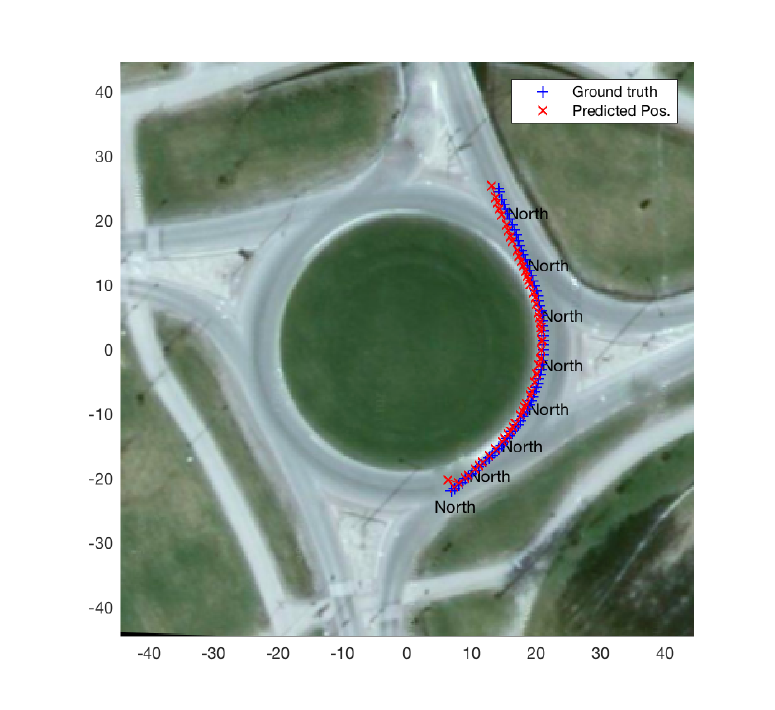
Figure 4. Exit direction classification and position prediction for a query trajectory inside a roundabout, using roundabout model based on a set of reference